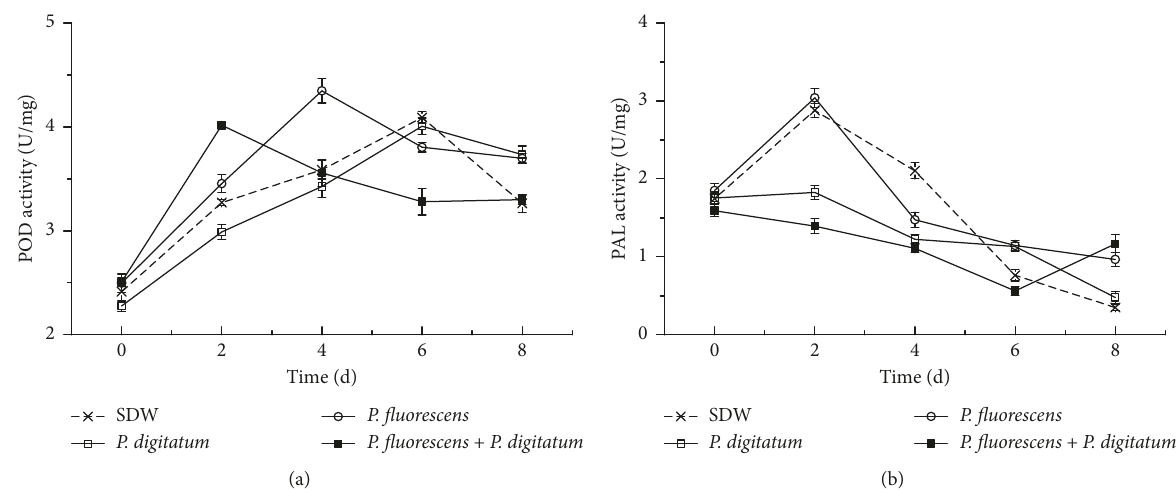
Figure 6: The effect of P. fluorescens on activities of POD (a) and PAL (b). Each value is the mean of three experiments. Bars represent standard